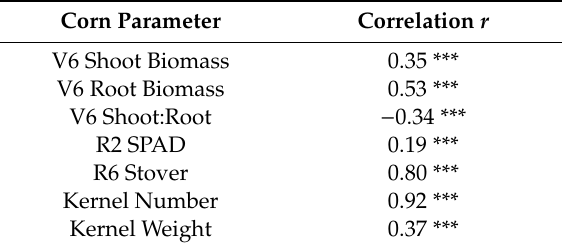
Table 10. Pearson correlation coe ffi cients and associated significance level for final grain yield between selected corn growth parameters for the continuous corn trial conducted at Champaign, IL during 2017 and